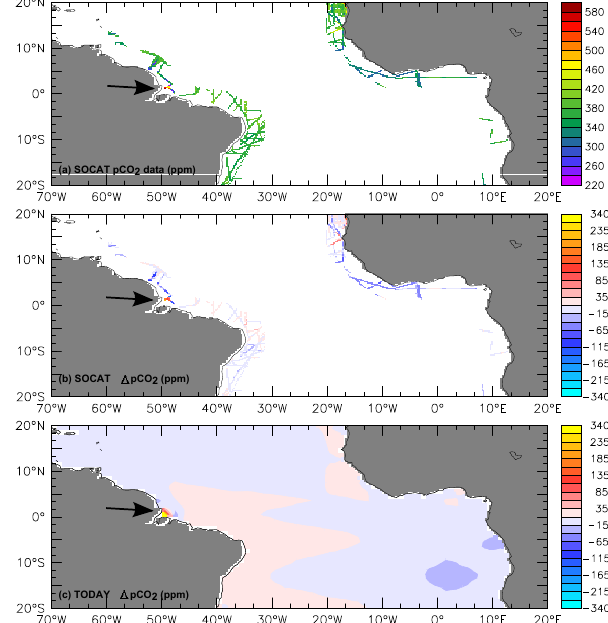
Fig. 5. (a) Coastal surface seawater p CO 2 data (in ppm) (a) from the SOCAT database (Pfeil et al., 2012b), (b) 1p CO 2 (SOCAT – at- mospheric p CO 2 from Ragged Point station, Barbados (373ppm)), (c) 1p CO 2 from the TODAY scenario (average 1998–2005). The black arrow indicates the high CO 2 area in the Amazon River mix- ing zone (SOCAT data from December